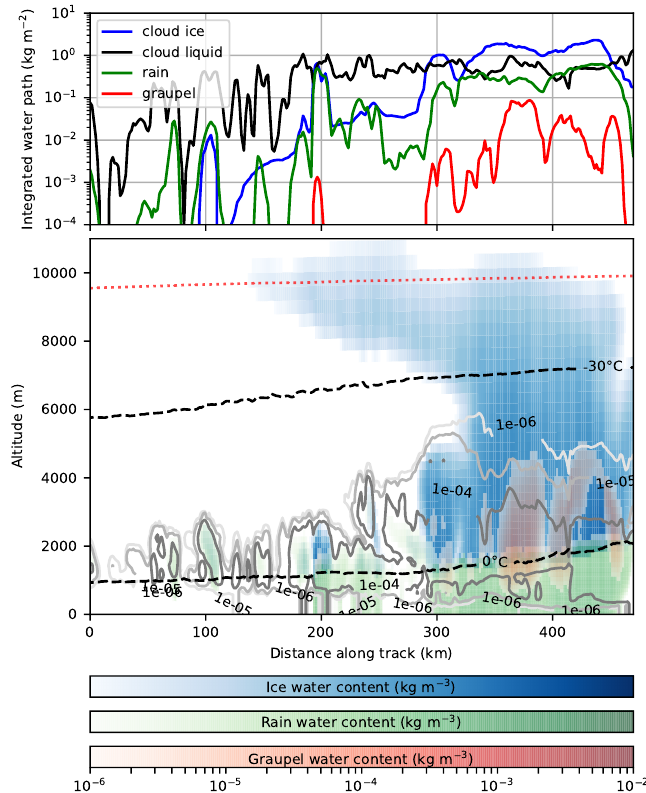
Figure 5. NWP model integrated water path (top) and hydrometeor mass content (bottom) along aircraft track for flight C161. The solid contours in the bottom panel represent the cloud liquid water content, the dashed black lines show the 0 and − 30 °C isotherms and the dotted red line indicates the aircraft